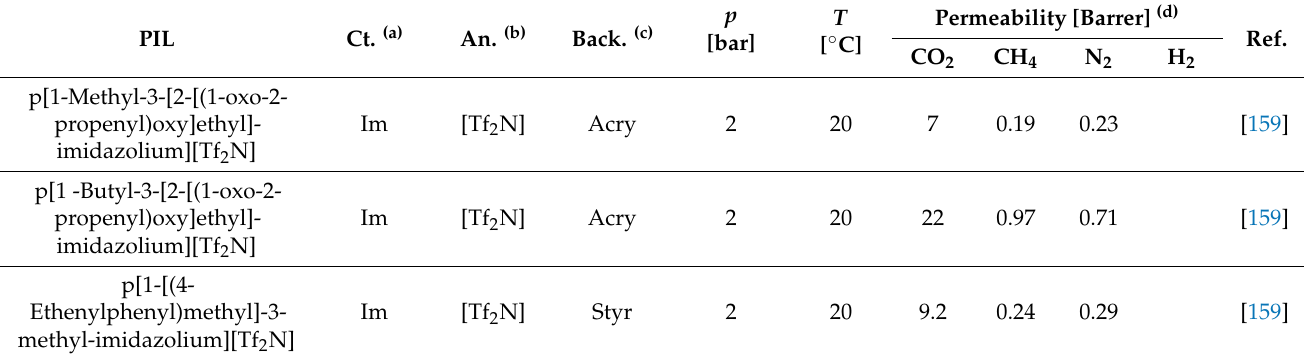
Table 5. Overview of the pure gas permeabilities for CO 2 , CH 4 , N 2 , and H 2 of a series of PILs. PIL Ct. (a) An. (b) Back. (c)